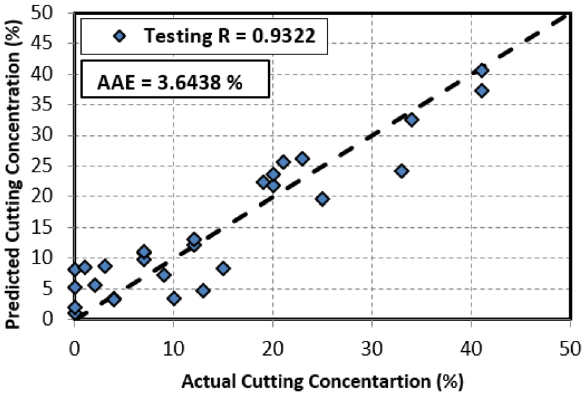
Fig. 16 SVM-predicted versus actual (experimental) cutting concen- tration from testing stage Table 5 Results of estimating C C using SVM